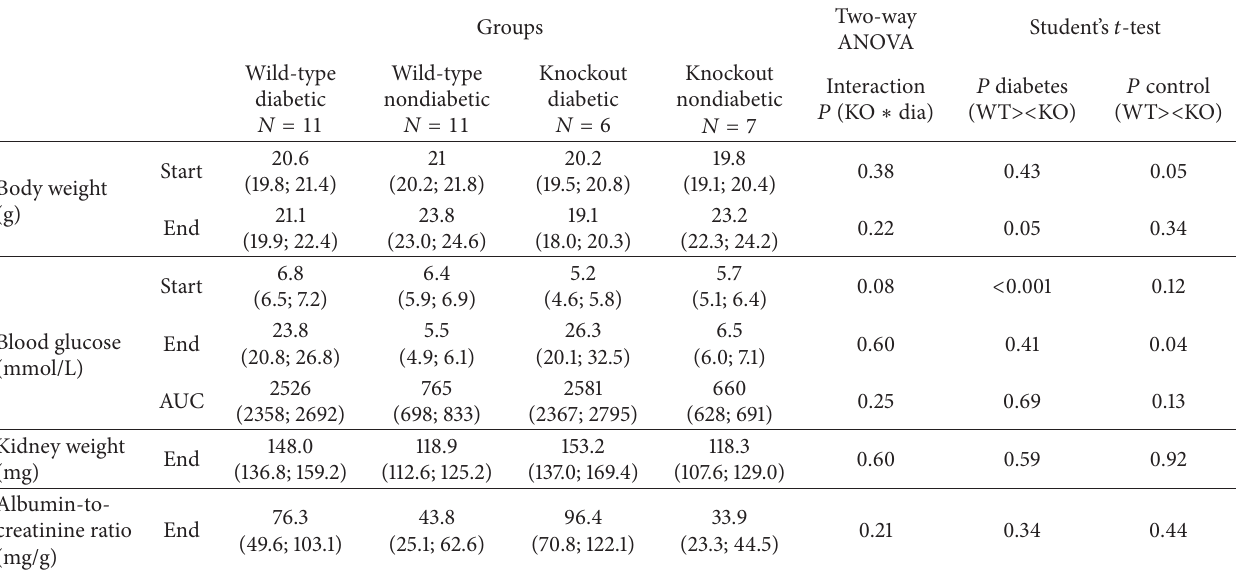
Table 1: Table illustrating mean (95% confidence